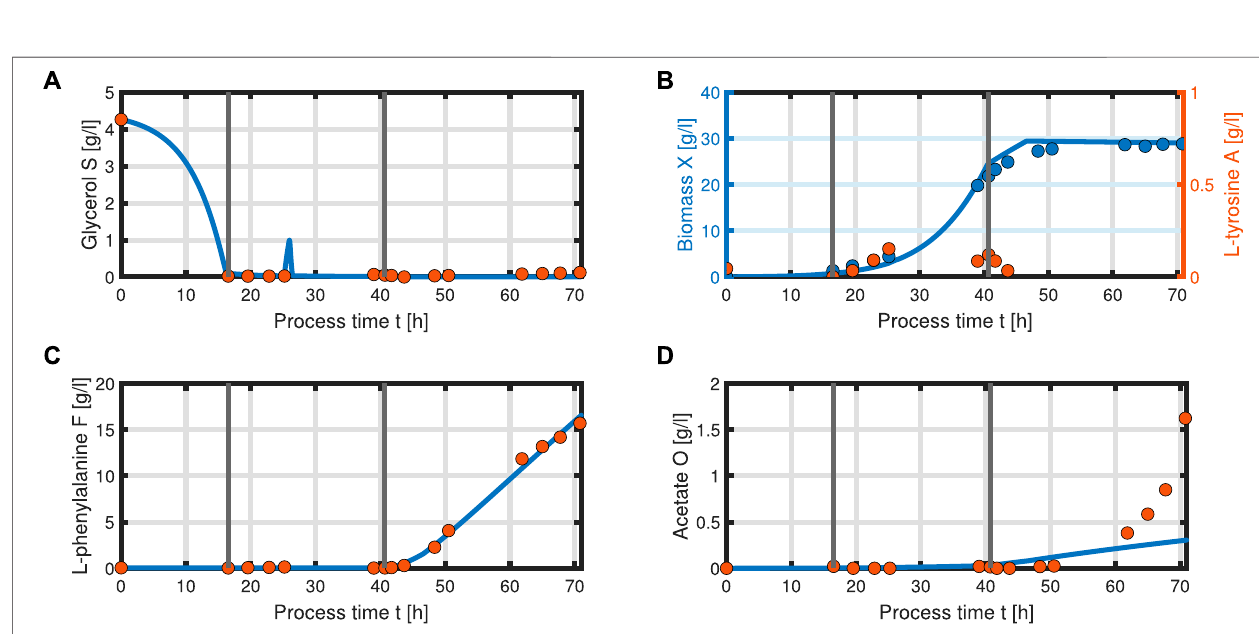
( Figure 7 ). Analogous to the experiments, the simulation is divided into different process phases, and slightly different parameter sets were used for the biomass and L-phenylalanine production phase. The parameter set for the product formation phase contains higher reaction constants for byproduct formation and respiration. After each process phase, the solution of the end point was used as the initial value for the differential equations for the next process phase. Parameter values used for this simulation can be found in Supplementary Materials . Figure 7 shows good agreement between the simulated concentrations of substrate S , biomass X , L-phenylalanine F , and the experimental data. The peak of substrate concentration S during the fed-batch phase can